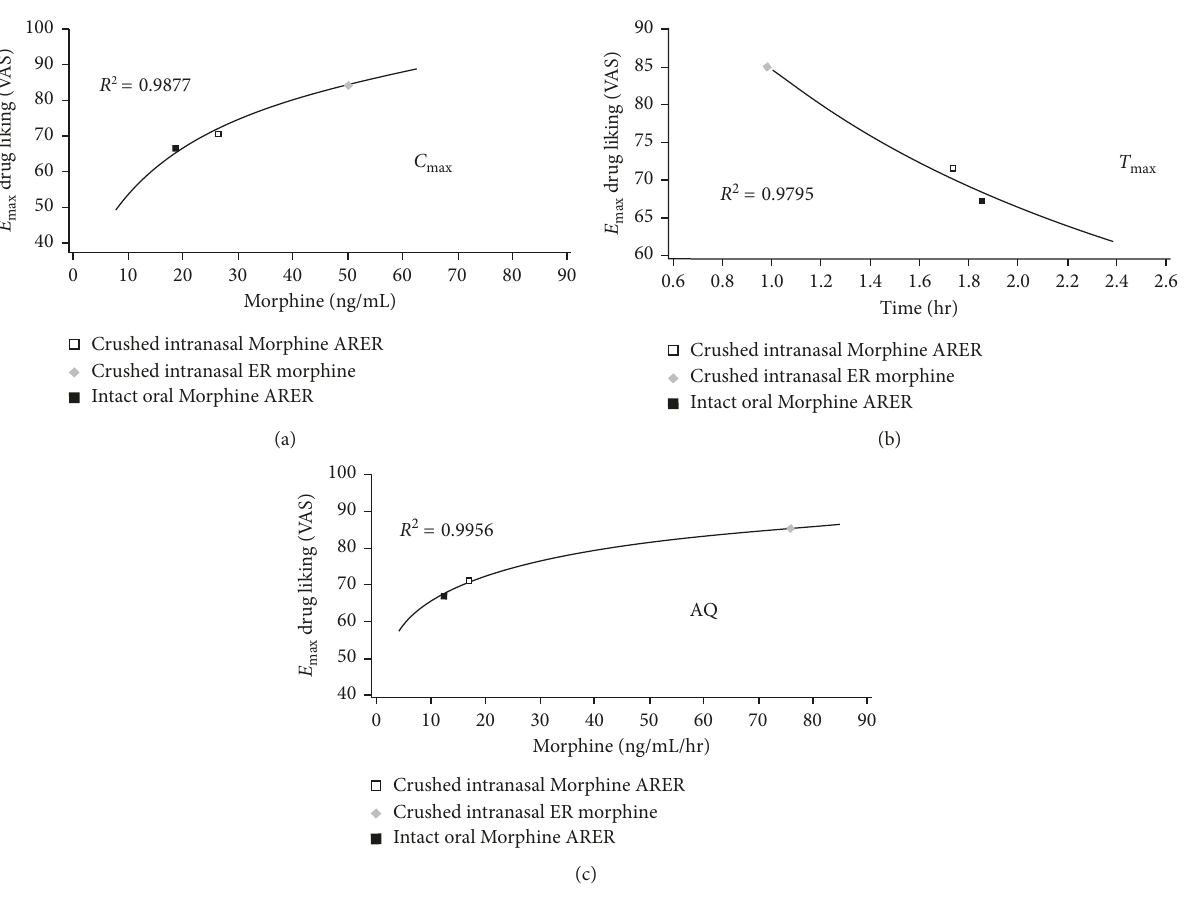
max for drug liking (a) VAS versus C max , (b) E max for drug-liking VAS versus T max , and (c) E max for 25). AQ abuse quotient, C max maximum observed plasma concentration, E max (cid:30) (cid:30) (cid:30) time to C max , VAS visual analog (cid:30) (cid:30)